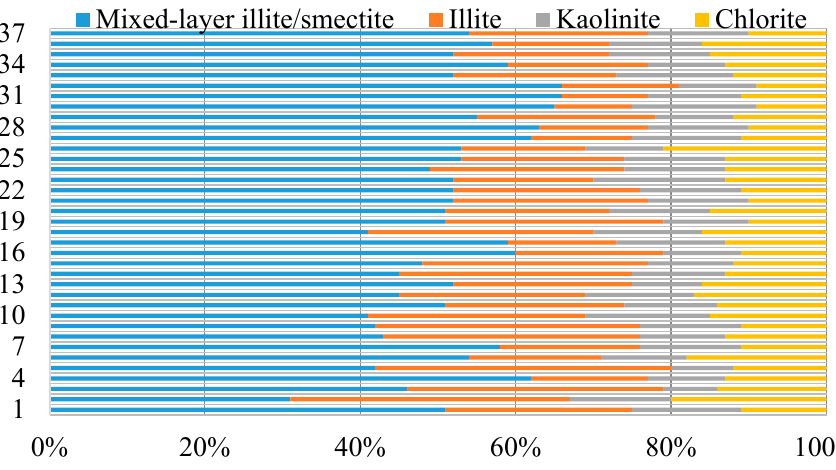
Figure 3. Histogram of the clay mineral composition of Da’anzhai shale, FY1 Well.